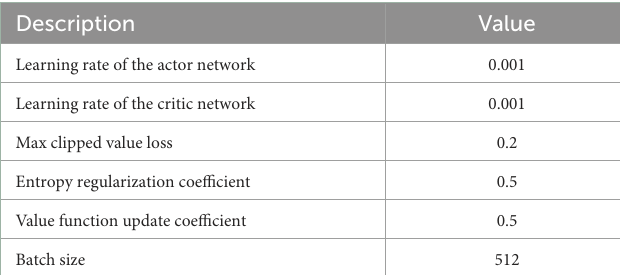
TABLE 5 The relevant parameters in the Trans-UTPA experiment.